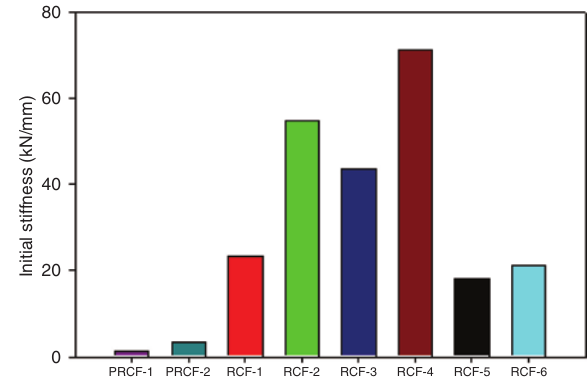
Figure 15: Initial stiffness of the test